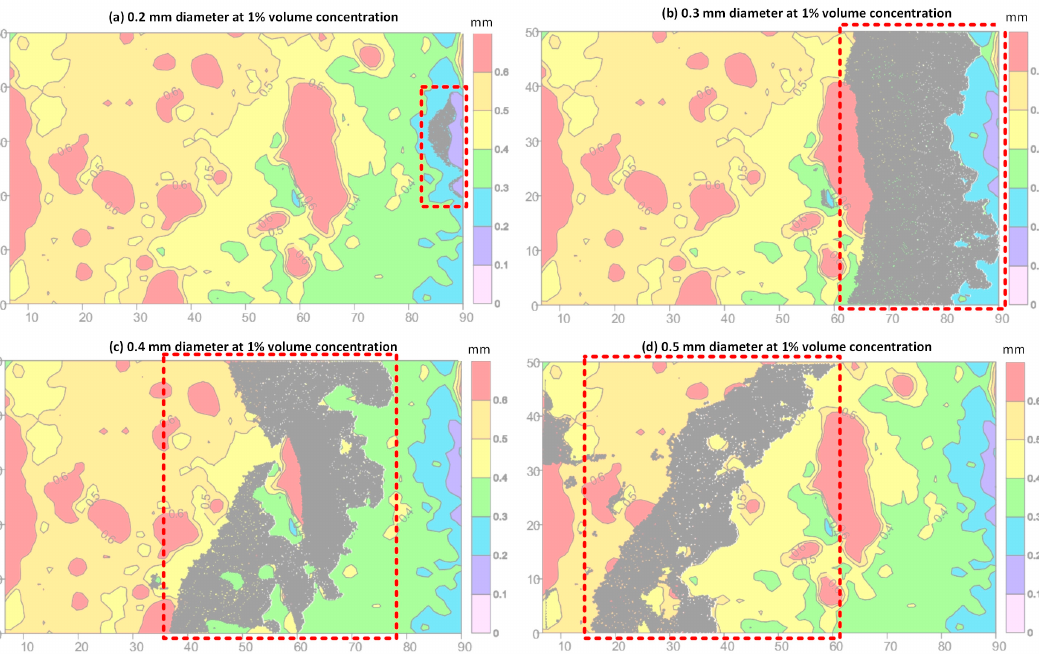
Figure 12. The distributions of different diameter LCM particles at the end of the simulation.